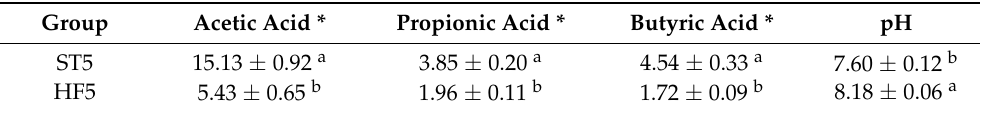
ST5: mice fed with a standard diet; HF5: mice fed with a high-fat diet. Data are shown as mean ± SEM. Means with different letters (a,b) indicate significant differences ( t test, p < 0.05). * µ moles/g of wet